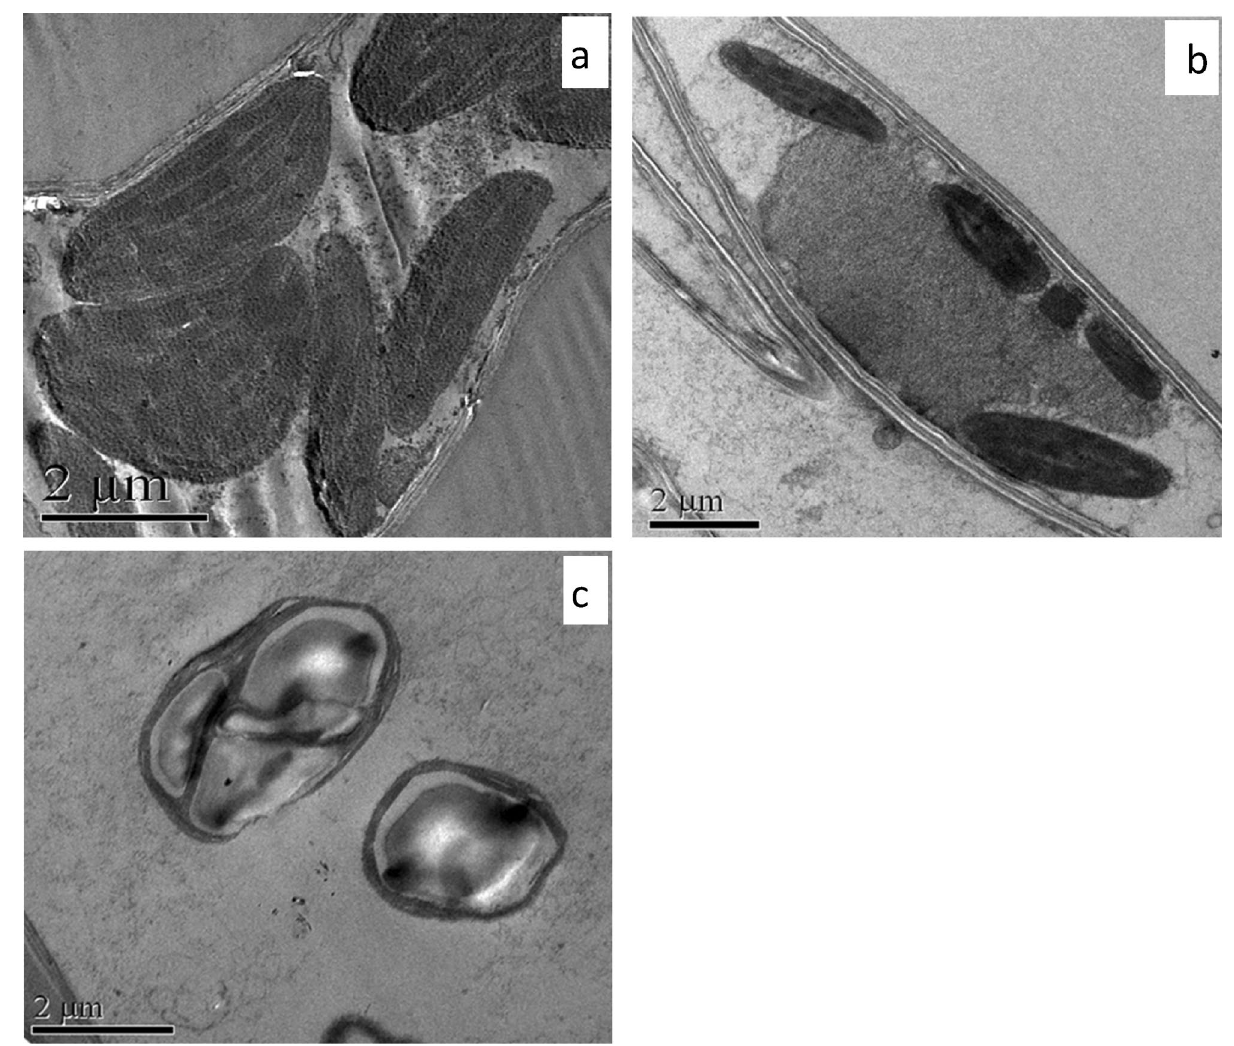
Figure 6. TEM micrographs of T. natans : ( a ) a young mesophyll cell of control plant showing numerous chloroplasts, ( b ) damaged and disintegrating chloroplasts in Sb treated plant, ( c ) disturbance in the orientation of the grana and starch accumulation in Sb treated